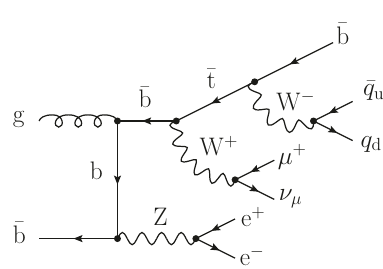
¯ b channel at O ( α s α 6 ) .